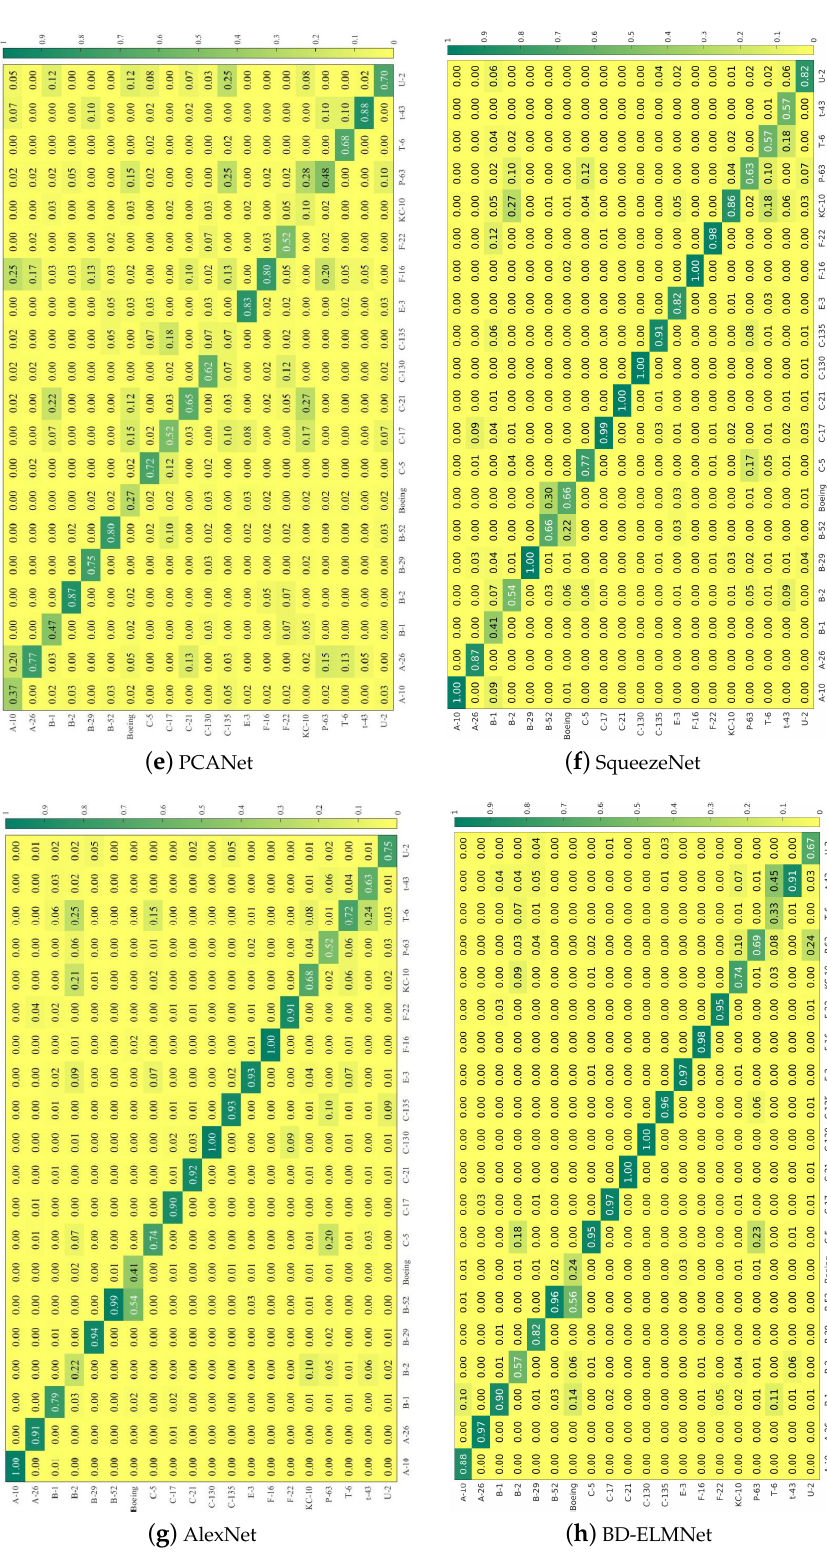
Figure 6. Confusion matrices for the LBP + SVM, BovW, ELM, CRF-ELM, PCANet, SqueezeNet, AlexNet and BD-ELMNet on the MTARSI